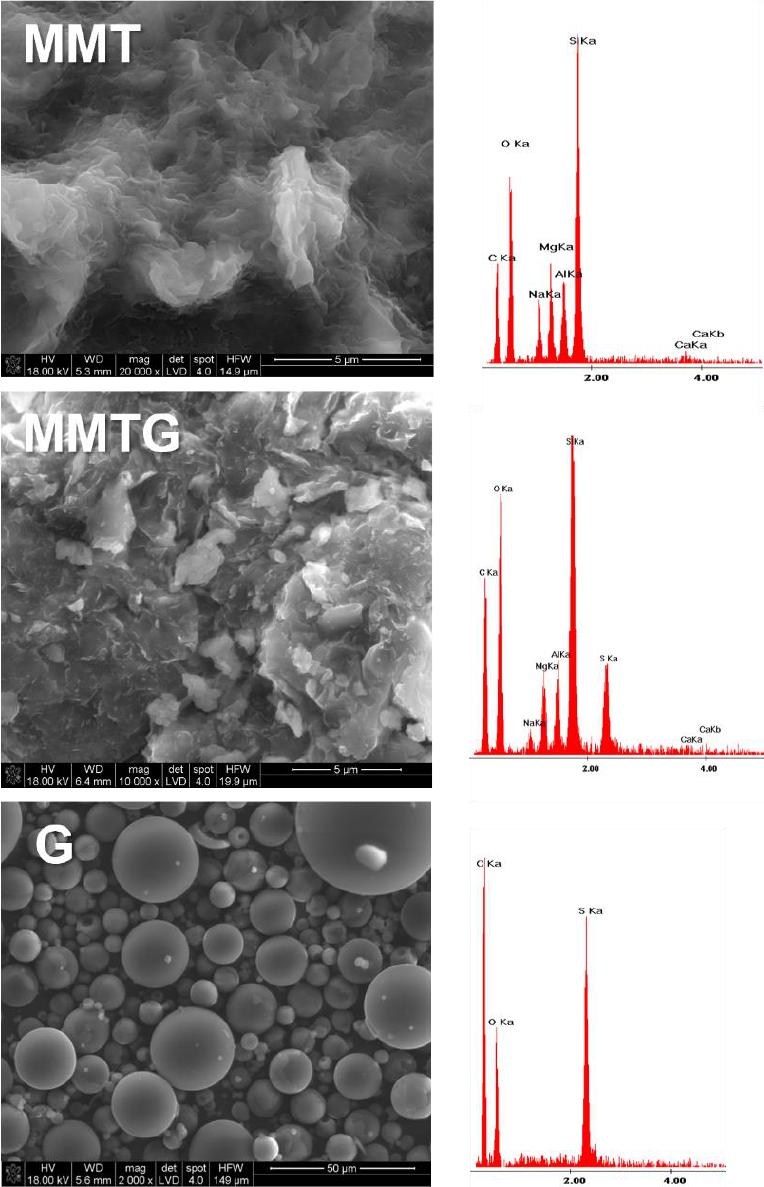
Figure 3. SEM image of the MMT, MMTG and G powders with EDS analysis (average analysis of the observed microarea).